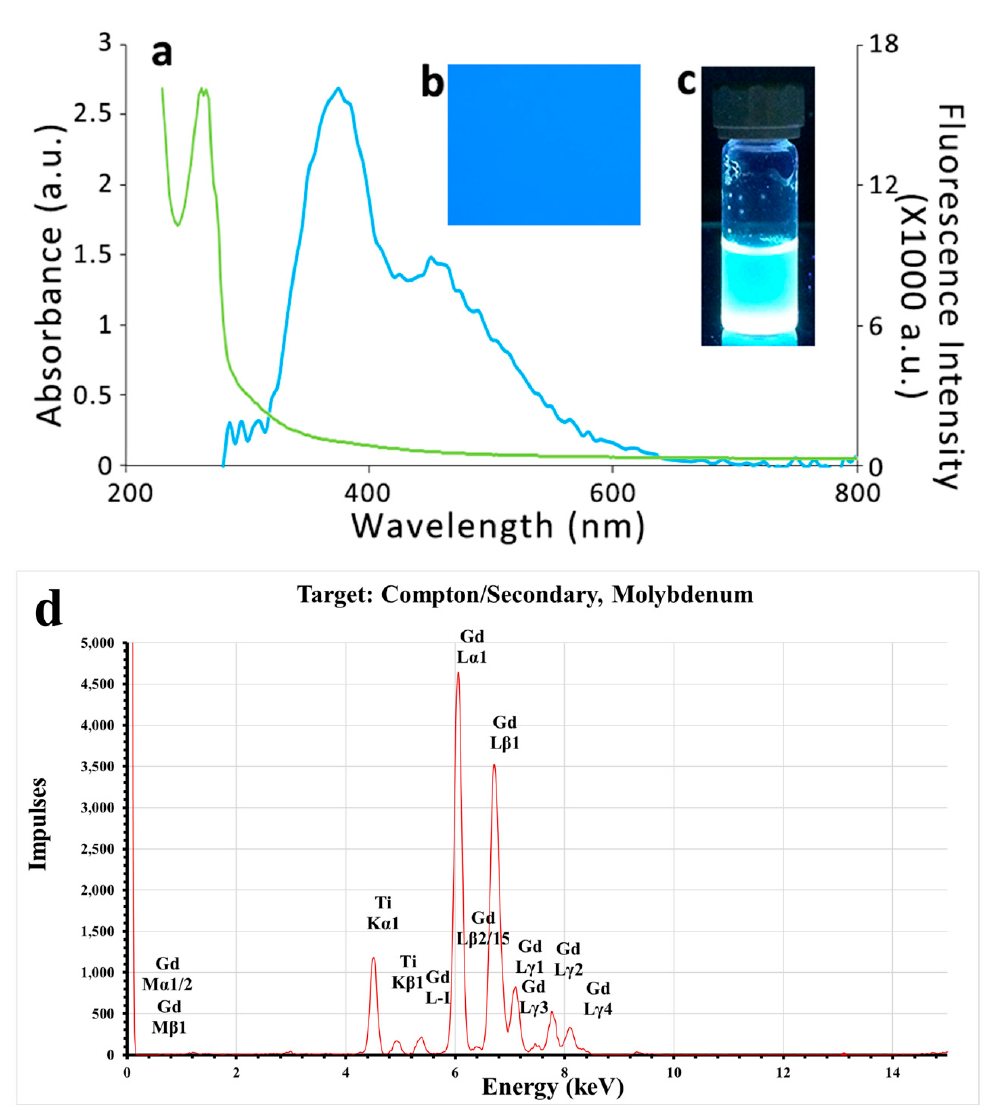
Figure 3. The scale of the current measured on the bare glassy carbon (GC) was from 0.09 to 0.2 nA. The GC immobilized with TGQD showed a current range mainly from 0.6 to 0.7 nA. Thus, it can be concluded that the current interval in both cases was the same (almost 1 nA). Hence, the inhomogeneity of both electrodes is comparable. It can be concluded that the homogeneity of the both electrodes is mainly a ff ected by the Nafion layer. However, the current increased significantly in the presence of the TGQD. This can be attributed to the good electrochemical conductivity of the synthesized TGQD, which is due to low electrochemical resistance of their metallic components. Moreover, the charge of the QDs may influence their electrochemical conductivity. However, we found that the TGQDs were water soluble and showed high stability (fluorescence measurement) in solution, even after four solution, even after four months from its prepared time. months from its prepared time.